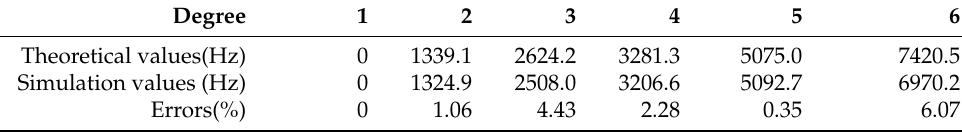
Table 3. Comparison of natural frequency simulation value and theoretical value.